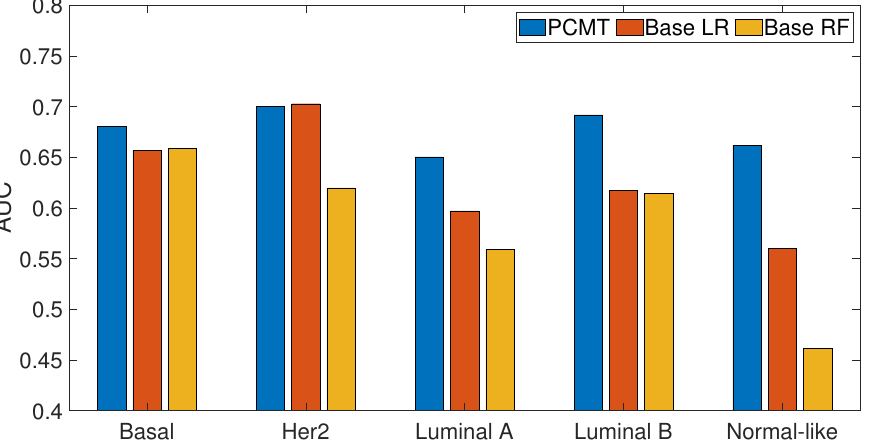
Figure 7. Prediction accuracy of subtype specific classifiers for PCMT, base LR and base RF